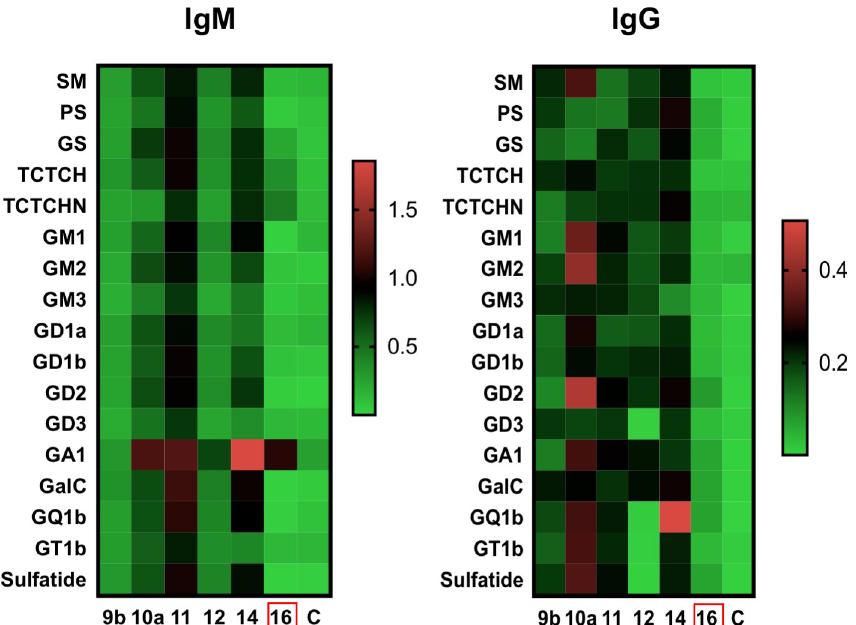
Fig 5. IgM and IgG reactivity of plasma from high-responder Zika patients with GBS. Heatmap of plasma IgM and IgG reactivity to individual glycolipids, expressed as optical density values from the specific ELISAs. The patient with GBS of unknown etiology (16) is marked with a red rectangle. Control uninfected plasma (C).